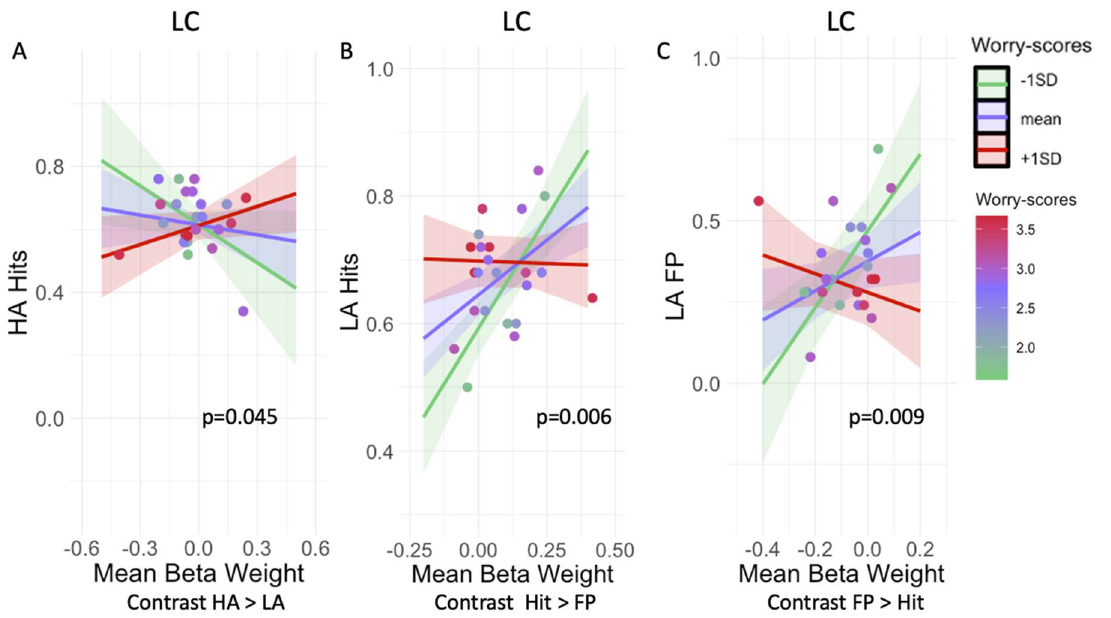
Figure 4. Visualization of the interaction between worry and LC activation on memory performance. ( A ) lower LC activity under high arousal is associated with higher hits for participants with a low compared to a high level of worry ( B ) Under low arousal higher LC activity for Hit trials than FP is associated with a higher proportion of hits in participants with low compared to high levels of worry ( C ) for participants with low compared to a high level of worry less deactivation of the LC is asso- ciated with more FP under low arousal. For visualization purposes the continuous variable worry is depicted as mean and +/− 1SD, as analyses were done with worry and activation as continuous variables (see Table 3). The color of the dots represents the continuous worry score of the partici- pants. Abbreviations: LC = locus coeruleus, FP = false positives, HA = high arousal, LA = low arousal. Table 3. Effect modification of worry on the association between activity (memory and arousal con- trasts) and memory performance.